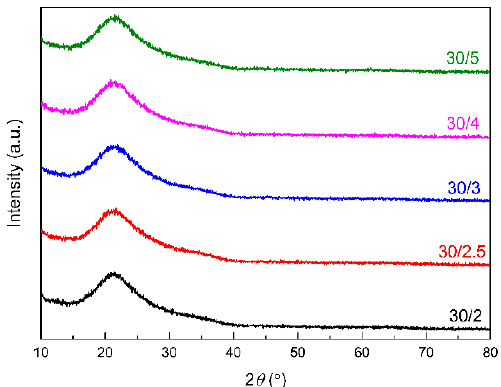
Figure 2. XRD patterns of the TaO x films with different Ar/O 2 ratio deposited on silica glass substrates. The surface and cross-sectional morphologies of the TaO x films are shown in Figure 3.